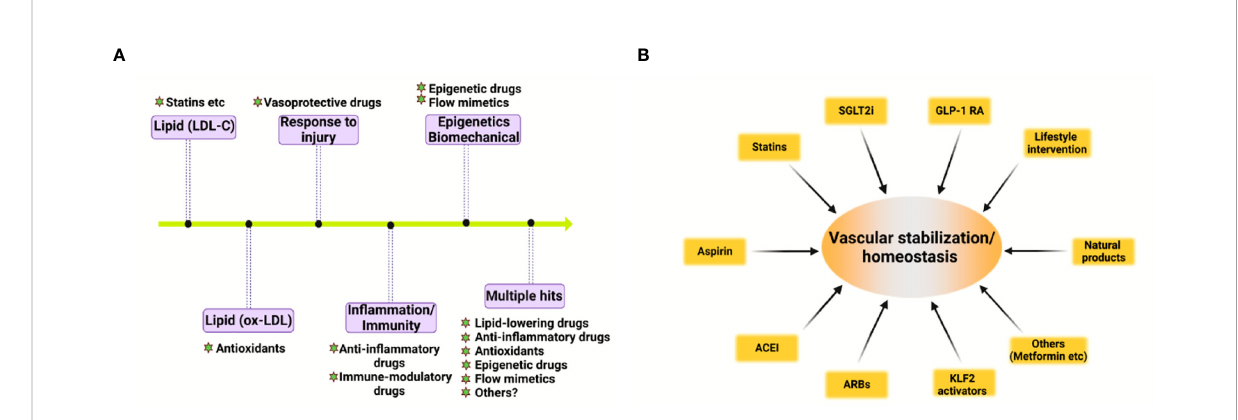
FIGURE 2 Evolving hypothesis of atherosclerosis and vascular homeostasis-targeted therapies. (A) Evolving hypothesis of atherosclerosis. (B) Pharmacological and non-pharmacological strategies to promote vascular stabilization and homeostasis and to prevent atherosclerosis. ACEI, angiotensin-converting-enzyme inhibitors; ARB, angiotensin II receptor blockers; SGLT2i, sodium-glucose cotransporter 2 inhibitor; GLP-1 RA, glucagon-like peptide 1 receptor agonist; KLF2, kruppel-like factor